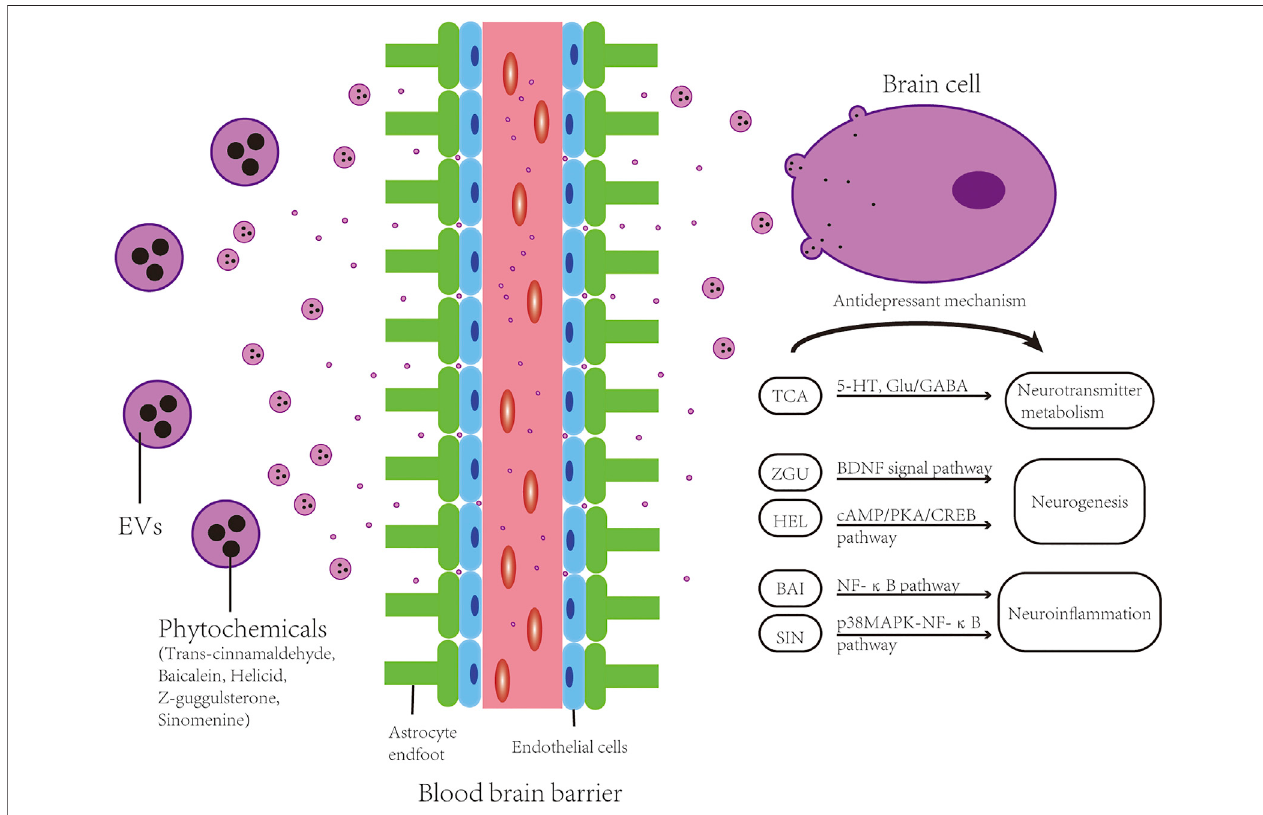
FIGURE 3 | EVs for DD treatment by drug delivery. Phytochemicals such as Trans-cinnamaldehyde (TCA), Baicalein (BAI), Helicid (HEL), Z-guggulsterone (ZGU) and Sinomenine (SIN) can be packaged into extracellular vesicles and conveyed through the BBB to the brain cells (neurons and neuroglial cells), and exert antidepressant effect by regulating neuroin fl ammation, neurogenesis and neurotransmitter metabolism through a variety of pathways.